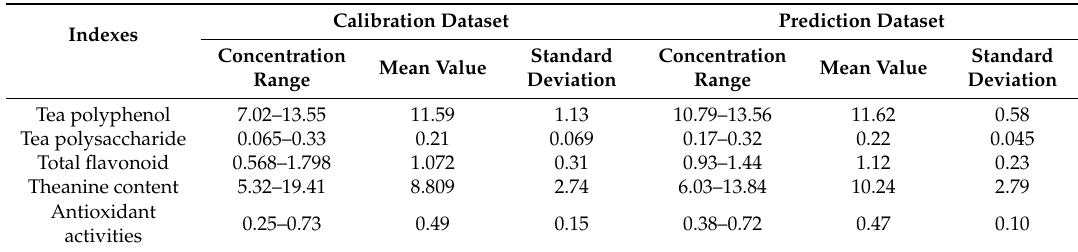
Table 1. Samples in calibration dataset and prediction dataset.